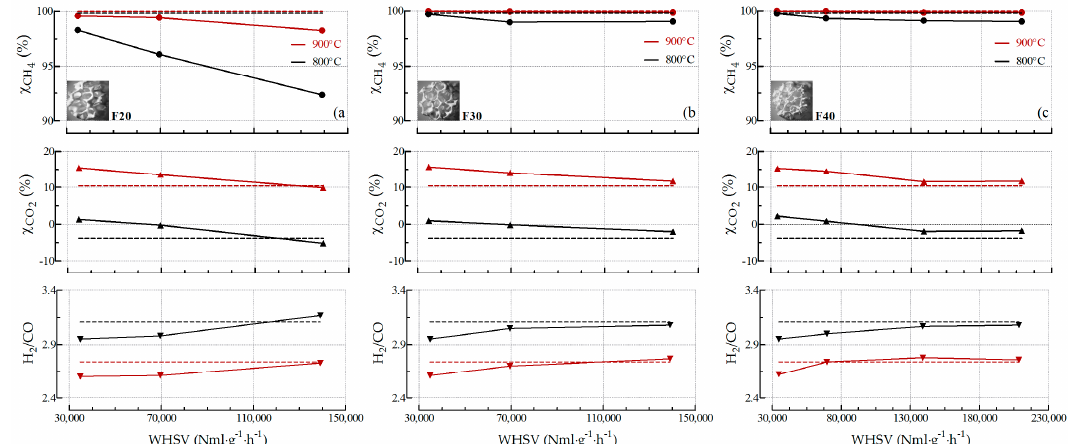
Figure 10. Biogas SR activity (S/CH 4 = 3) over F20 ( a ), F30 ( b ) and F40 ( c ) catalysts. Influence of temperature (T SET = 800–900 ◦ C) and space velocity (WHSV = 35,000–140,000 NmL · g − 1 · h − 1 ) on CH 4 conversion and H 2 /CO molar ratio (thermodynamic data reported as dotted lines).